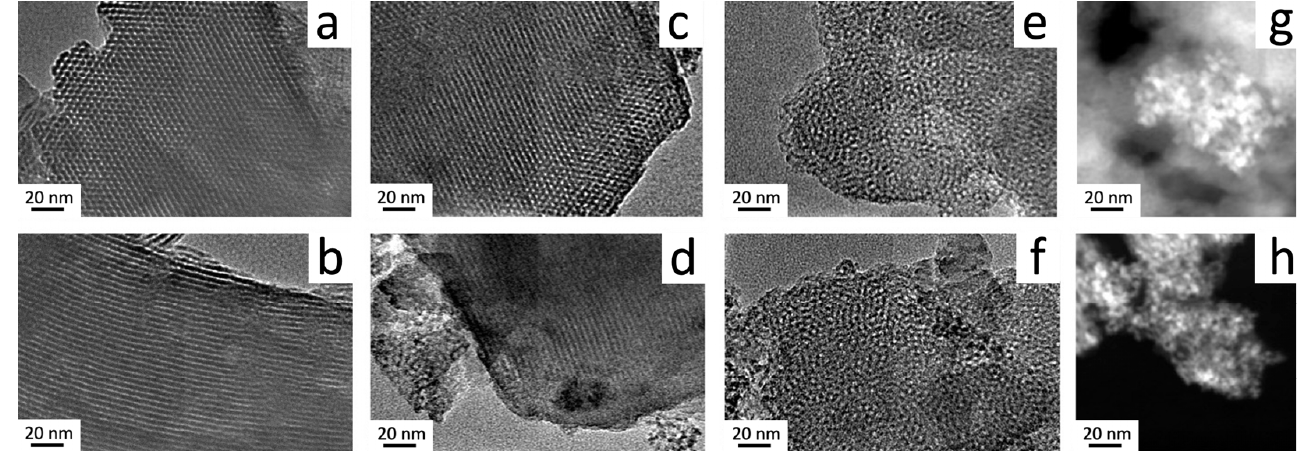
Figure 4. HR-TEM: ( a ) Cross sectional area of the hexagonal structure and ( b ) view along the channels for MCM-41; ( c ) Hexagonal structure and ( d ) interplanar distance for 0.02Ce-MCM-41_US; ( e ) 0.04Ce-MCM-41_US and ( f ) 0.06Ce-MCM-41_US; ( g ) High-Angle Annular Dark-Field Imaging for CeO 2 particles in 0.08Ce-MCM-41_US and ( h ) 0.06Ce-MCM-41_US. (Bar length = 20nm for all mi-